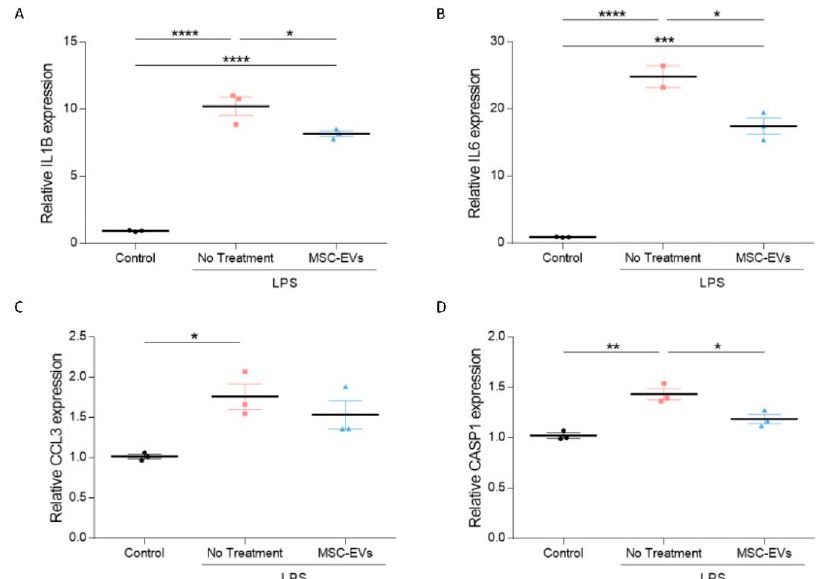
Figure 2. Mesenchymal stem cell-derived extracellular vesicles (MSC-EVs) have an anti-inflammatory effect on activated BV2 microglia cells. mRNA expression analysis of Il1 β ( A ), Il6 ( B ), Ccl3 ( C ), and Casp1 ( D ) in control or lipopolysaccharide (LPS)-activated BV2 cells with and without MSC-EV treatment (primers are listed in Table 1). Data are presented as mean ± SEM, * p < 0.05, ** p < 0.01, *** p < 0.001, **** p < 0.0001, one-way Table 1. Primers for RT-PCR.